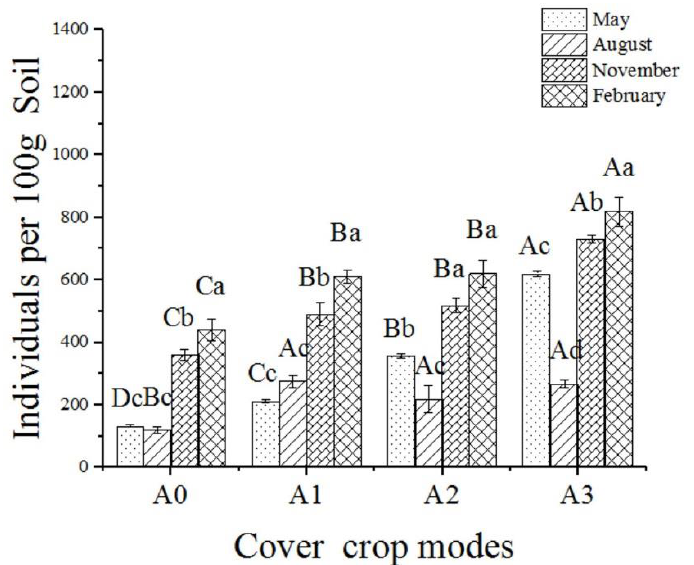
Figure 1. Variation of nematode abundance under different cover crop patterns. Note: A0 represents naturally covered of bare land; A1 represents mixed planting with two species; A2 represents mixed planting with four species, and A3 represents mixed planting with eight species. Different capital letters indicate the significant differences between different cover crop patterns in the same month, and different lowercase letters indicate the significant differences between different months of the same cover crop patterns ( p < 0.05).